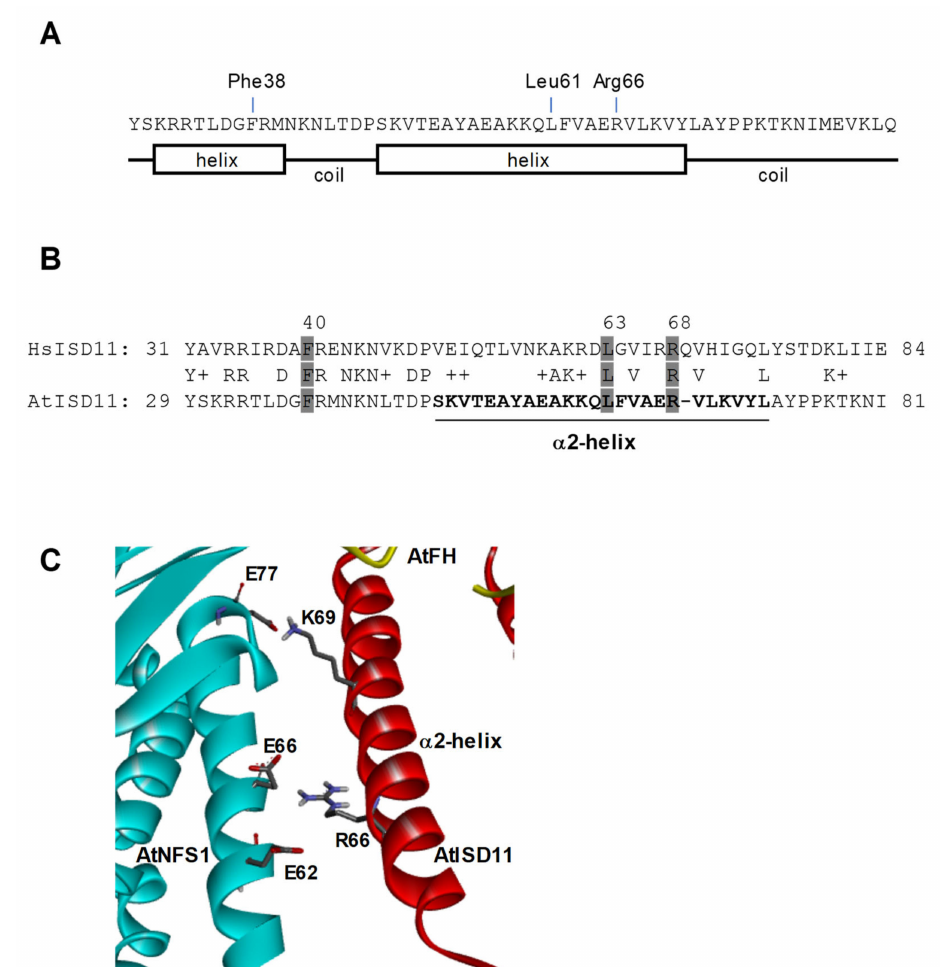
Figure 4. Secondary structure, sequence alignment and docking studies of AtISD11. ( A ) Secondary structure of AtISD11 showing the amino acids which interact with AtNFS1 in the protein complex. ( B ) Amino acid sequence alignment of human (HsISD11) and Arabidopsis (AtISD11) ISD11. Amino acids in grey are predicted to be critical for HsISD11 function. The region marked in bold, from Ser48 to Leu72 in AtISD11 is the second helix region ( α 2-helix) which interacts with AtNFS1. ( C ) Modeled interaction between AtNFS1 (light blue) and AtISD11 (red) showing important residues possibly involved in the